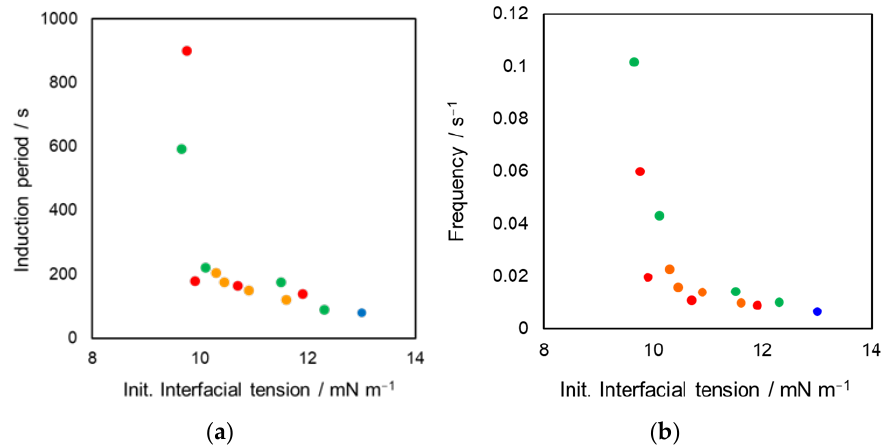
Figure 2. Relation between the oil–water interfacial tension of pendant-drop system without DEHPA and the oscillation characteristics; ( a ) induction period and ( b ) frequency; Each symbol indicates the additive in aqueous phase. ●: no additive, ●: ethanol, ●: methanol, ●: acetone. Each plot was based on duplicate experiments.